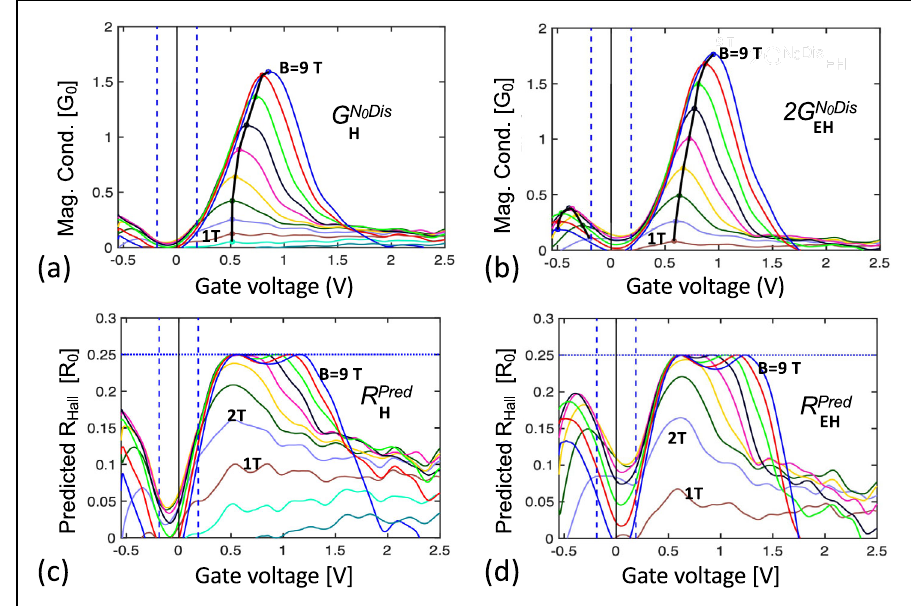
Fig. 8 | Anomalous quantum Hall plateau. a Magnetoconductance of N 0Dis , in unitsofG 0 forSeg. H . b Twicethemagnetoconductanceof N 0Dis forSeg.( E+H ),see text. Note the saturation near 2 G 0 as expected for N 0 in the quantum Hall regime. c , d Calculated quantum Hall resistance of Seg H and Seg. ( E + H ) from Eq. 4, that